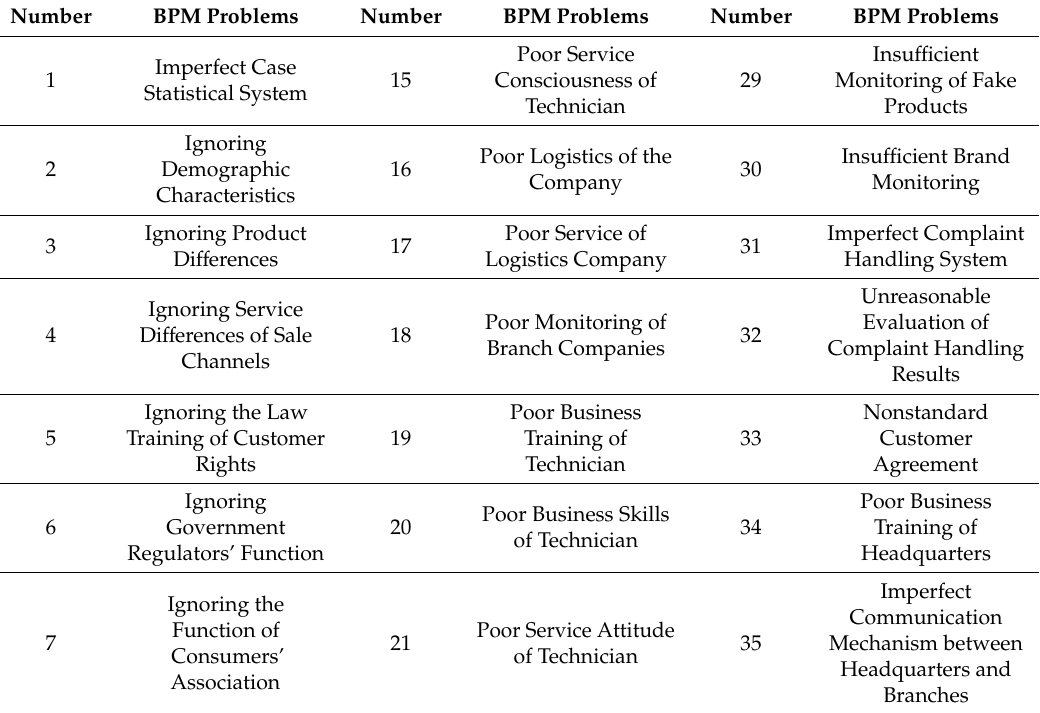
Table 1. Complaint handling process management